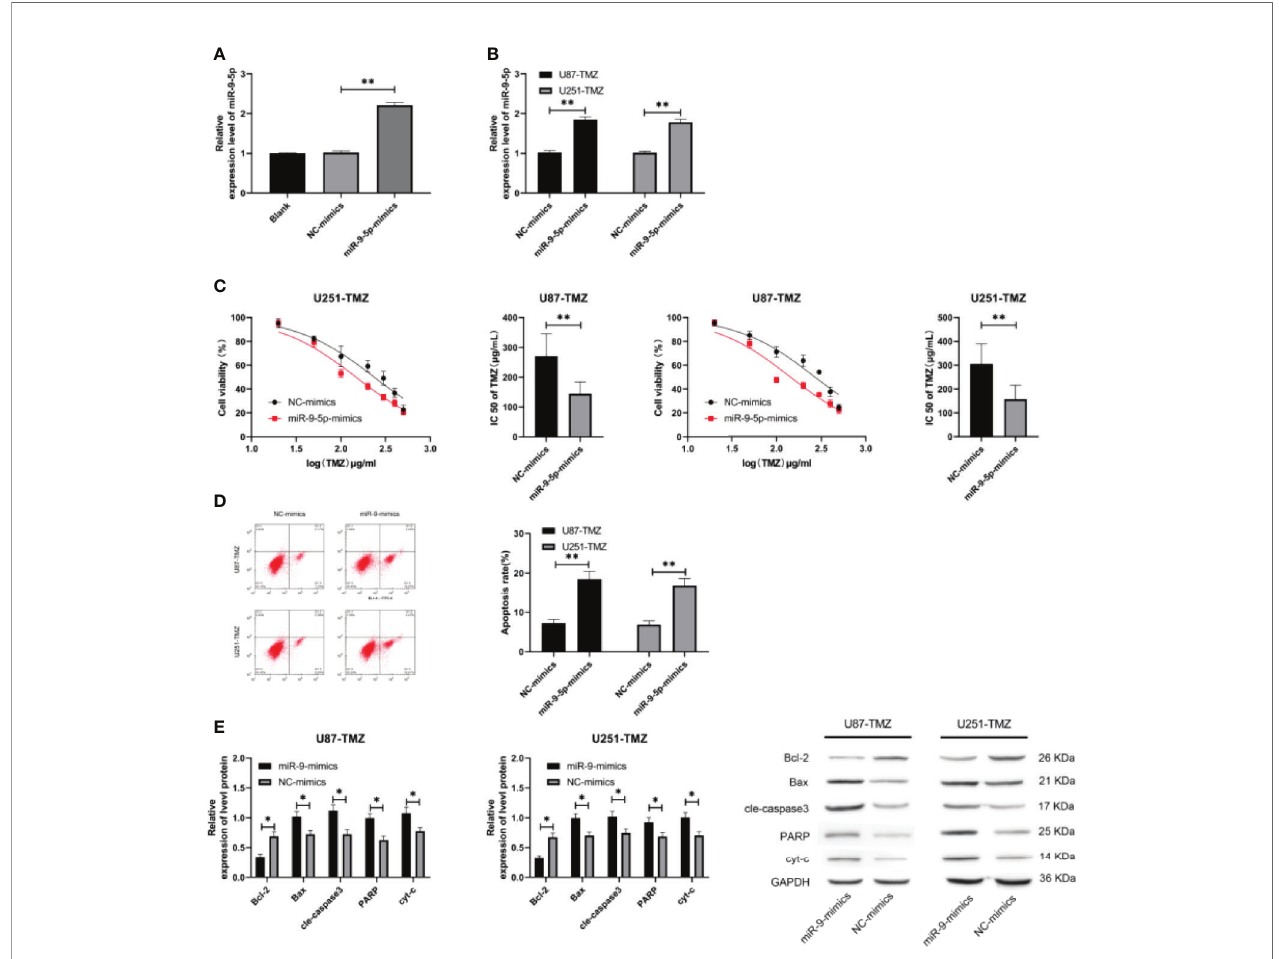
FIGURE 2 | Effects of regulating miR-9-5p on biological function of TMZ-resistant glioma cells. (A) qRT-PCR was used to detect the relative expression of miR-9-5p after constructing miR-9-5p-mimics plasmid. (B) qRT-PCR was used to detect the relative expression of miR-9-5p in U87-TMZ/U251-TMZ cells transfected with miR-9-5p-mimics. (C) MTT assay was used to detect the changes of U87-TMZ/U251-TMZ cell activity and IC50 after transfection of miR-9-5p-mimics. (D) Flow cytometry was applied to detect the change of apoptosis rate of U87-TMZ/U251-TMZ cells after transfection of miR-9-5p-mimics. (E) WB test was used to detect the changes of Bcl-2, Bax, cle-caspase3, PARP and cyt-c protein in U87-TMZ/U251-TMZ cells after transfection of miR-9-5p-mimics. * indicates P < 0.05; ** indicates P <